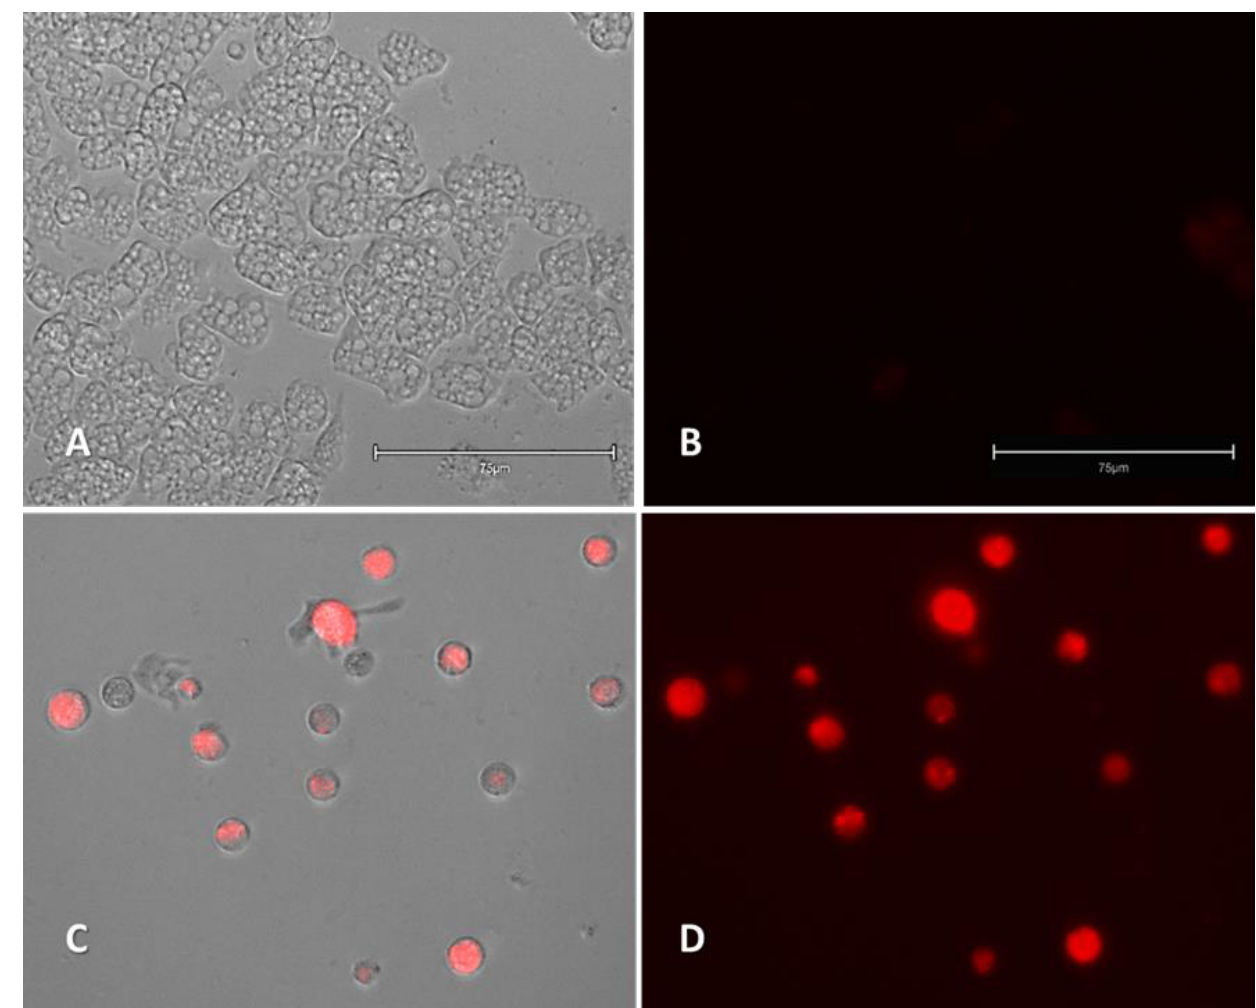
Figure 6. Increase in intracellular ROS levels (red fluoresncence) caused by the addition of compound 3 ( C , D ) at IC 90 after 24 h of incubation with Naegleria fowleri (ATCC ® 30808™). Negative control ( A , B ). The evaluated compound was added to the cells and exposed to CellROX ® Deep Red (5 μM, 30 min) at 37 °C in the dark. Images (40 ×) are representative of the cell population observed in the performed experiments. Images were obtained using an EVOS™ M5000 Imaging System, Invitrogen by Thermo Fisher Scientific, Madrid, Spain. Scale bars represent 75 µm.